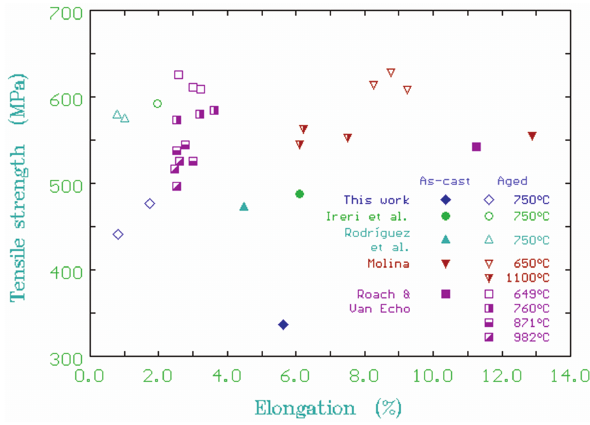
Figure 10: Changes in the tensile strength and ductility due to aging. Data from the literature are added for comparison [1, 9,